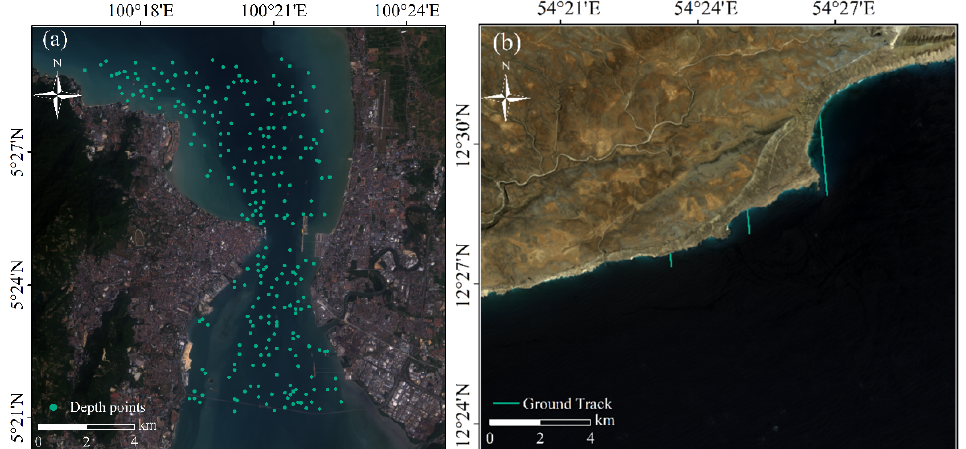
Figure 3. Image and depth point distributions. The control points and check points were randomly selected at a ratio of 2:1, and the points in each water depth section were as close as possible. ( a ) For Penang, there were a total of 266 depth points. ( b ) Socotra provided a total of 312 depth points. The Figure contains three ground tracks of ICESat-2, and the points are distributed along the track.